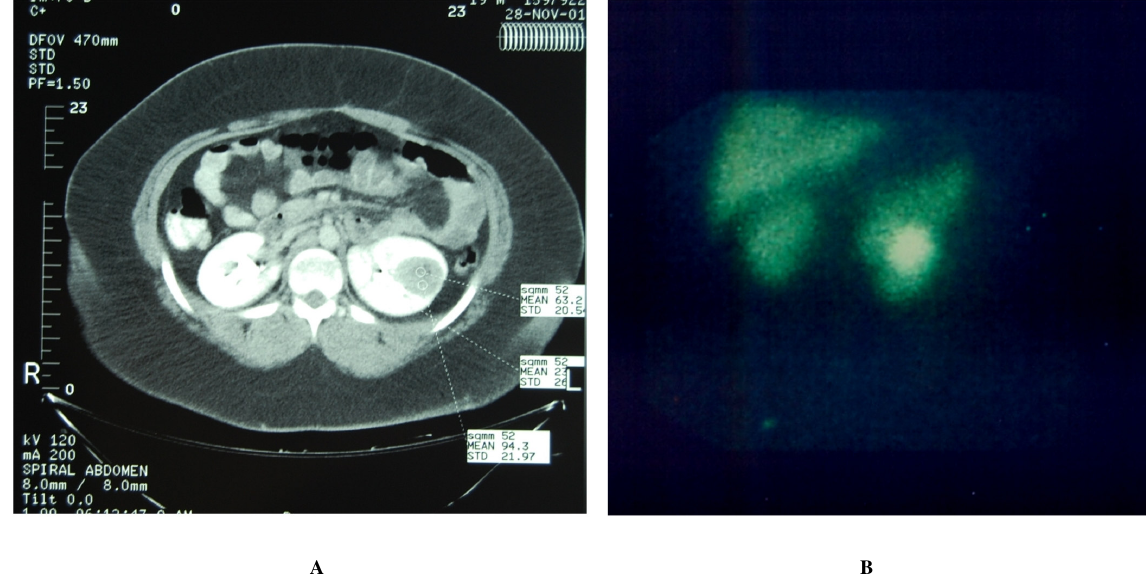
FIGURE 1 . (A) CT scan of the abdomen showing a 4- x 4-cm renal mass lesion in the interpolar region of the left kidney with central hypodensity. (B) Indium-111–labeled octreotide scan showing a focus of increased uptake in the mid-portion of left kidney consistent with a somatostatin receptor-positive